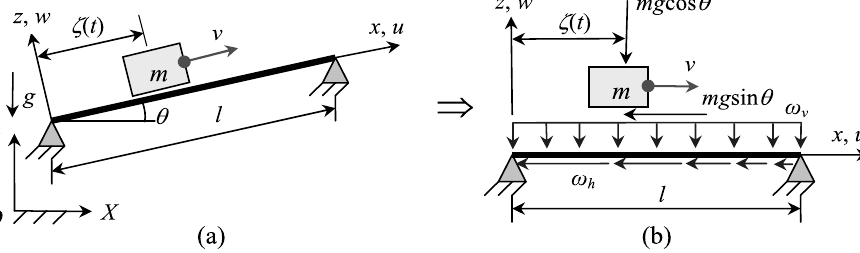
Fig. 1. (a) A mass traveling on an inclined pinned-pinned Timoshenko beam; (b) Equivalent moving mass model on a self-weight Timoshenko beam with fi xed